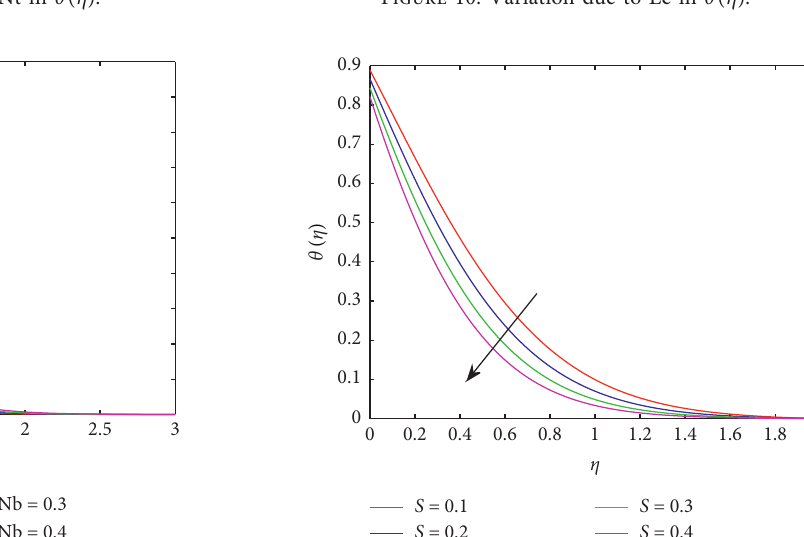
Figure 10: Variation due to Ec in θ ( η )